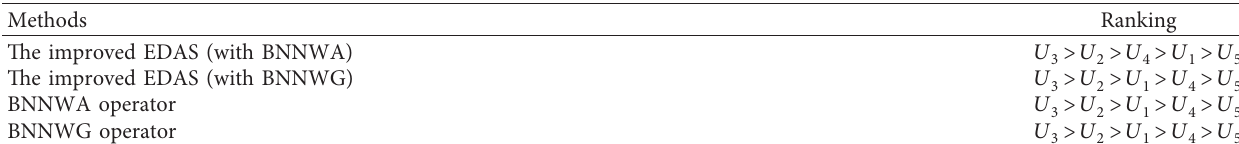
Table 14: The comparison results.